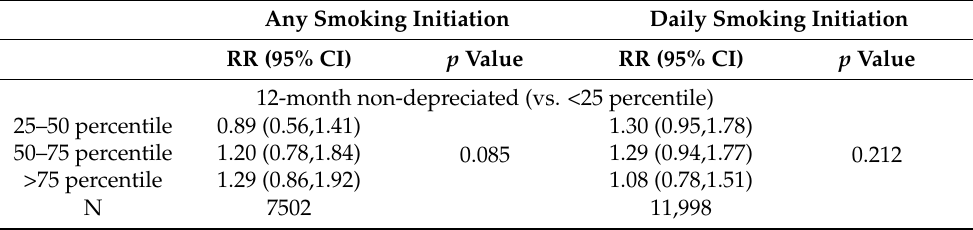
Table 2. Relative risk in media exposure (state + Truth) on any smoking initiation and daily initiation at modal age 19/20, monitoring the future longitudinal sample, baseline year 2001–2015. Results reflect imputed data (m = 10).